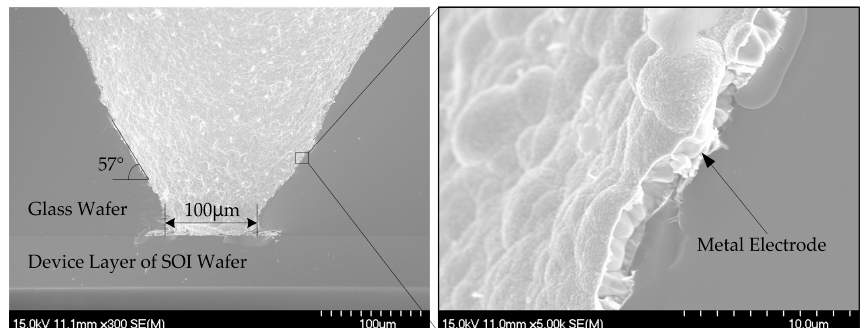
Figure 3. SEM images of the conical through vias on the glass with metal electrodes and their enlarged views.